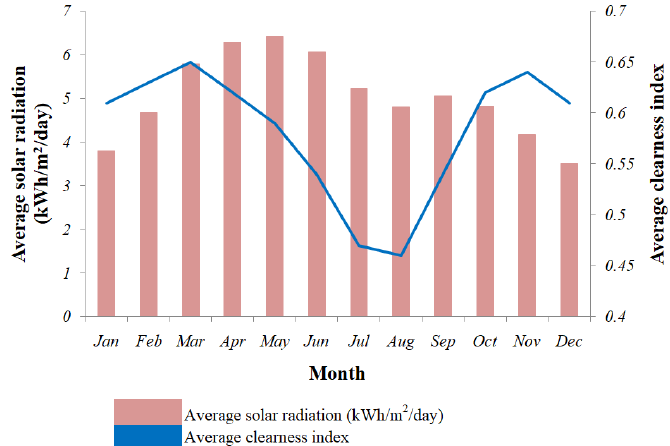
Figure 2. ALLSKY INSOL & clearness index of the selected region.